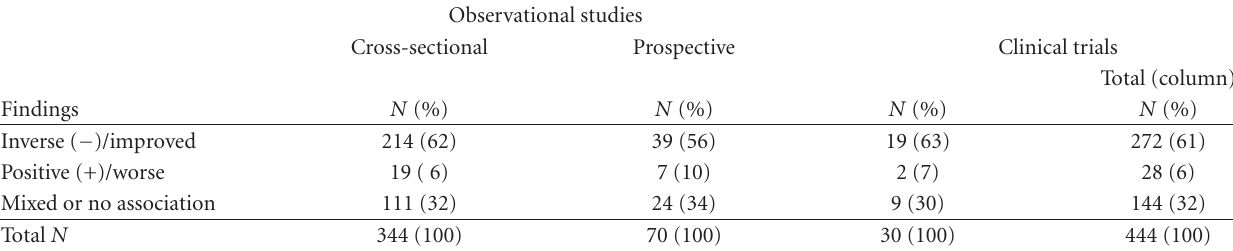
Table 1: Systematic review on depression and religiosity/spirituality